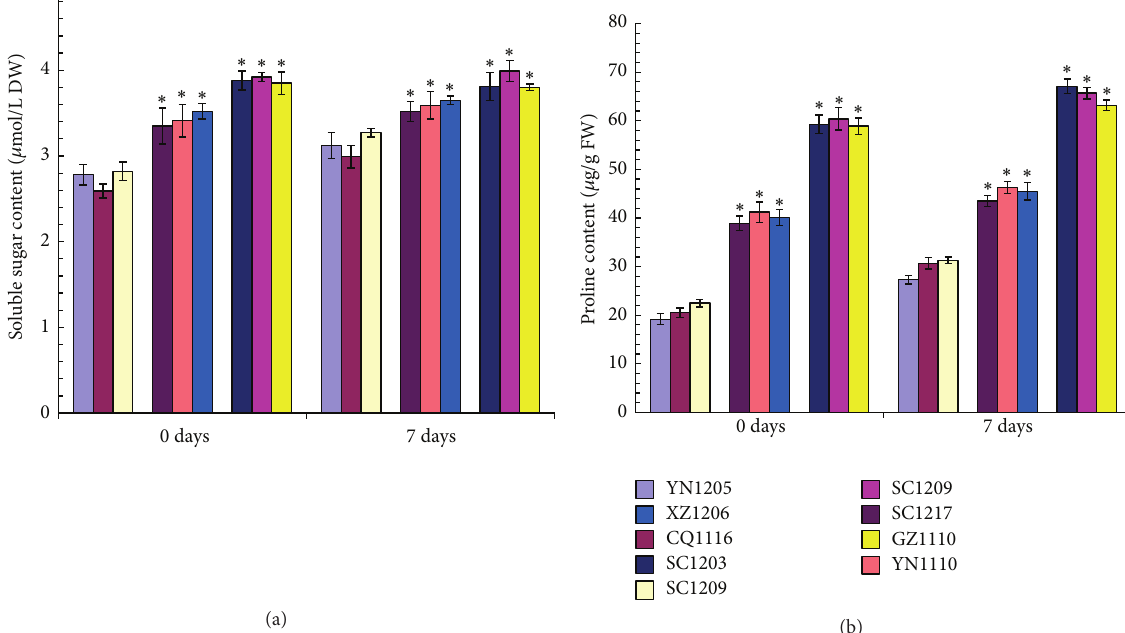
Figure 3: Comparison of soluble sugar (a) and proline (b) in leaves from nine selected C. dactylon accessions in response to SO 2 stress. Mean values are presented with vertical error bars representing the standard deviations ( 𝑛 = 3 ). The asterisk symbols indicate significant differences between SO 2 -sensitive accessions and SO 2 -tolerant